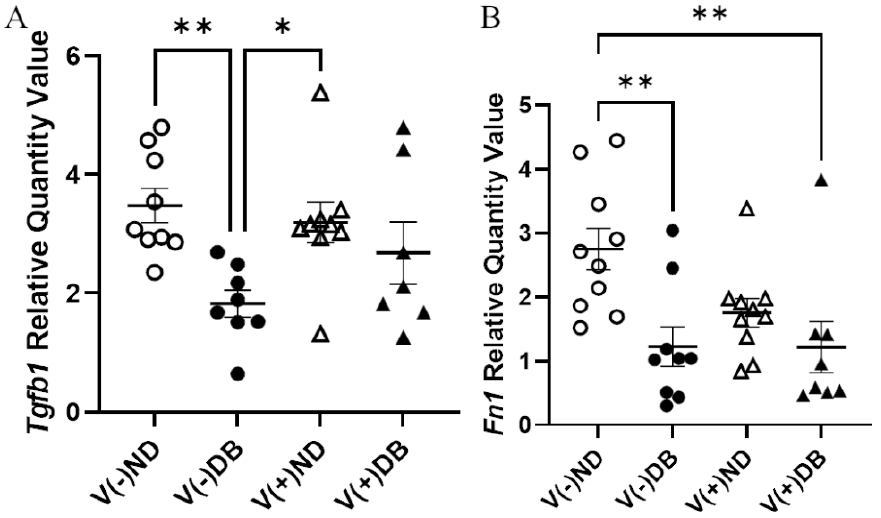
Figure 2. Body weight, kidney weight, and normalized kidney weight: ( A ) body weight, ( B ) kidney weight, and ( C ) normalized kidney weight were measured and compared across all four NOD mouse groups ( n = 7–9; * p < 0.05, ** p < 0.01, *** p < 0.001, **** p < 0.0001; V( − )ND, V( −